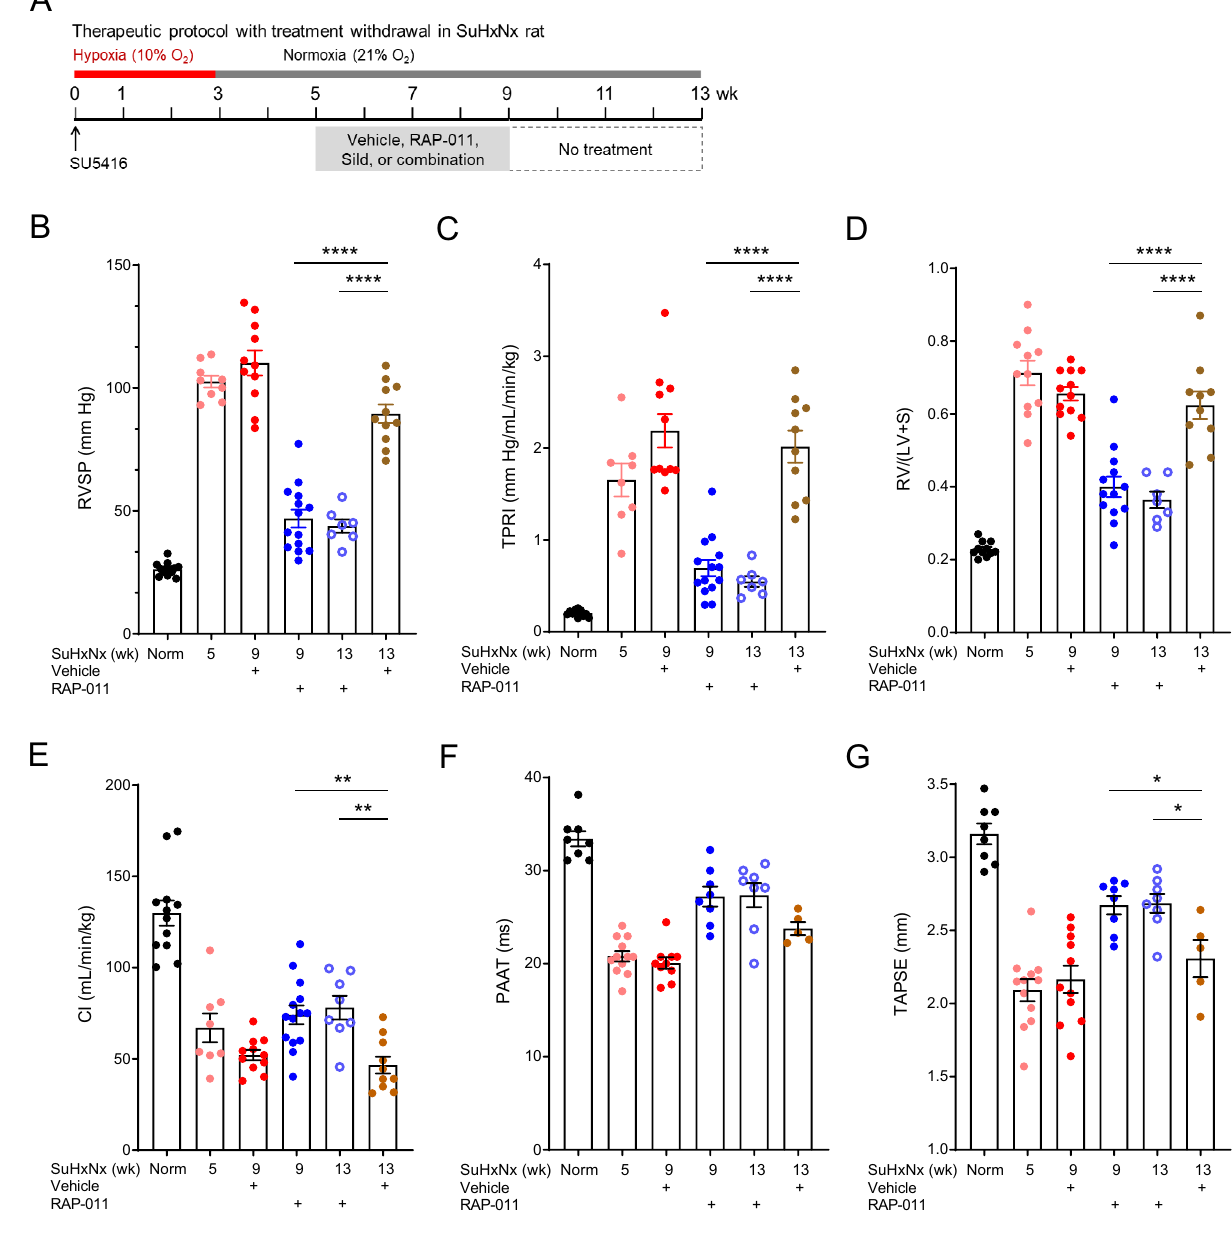
Figure 6. Disease-reversing effects of ActRIIA-Fc in severe experimental PAH persist after treatment cessation. ( A ) Experimental approach used to evaluate the persistence of therapeutic effects of RAP-011 in a SuHxNx rat model of severe PAH. Rats were treated on day 0 with a single dose of SU5416 (20 mg/kg, s.c.) and exposed to 3 weeks of normobaric hypoxia (10% O 2 ) followed by 10 weeks of normoxia to allow disease progression. Rats were additionally treated twice weekly with RAP-011 (2.5 mg/kg, s.c.) or vehicle (PBS) from week 5 to week 9 post SU5416, at which time treatment was discontinued for the remaining 4 weeks. ( B ) RVSP, ( C )